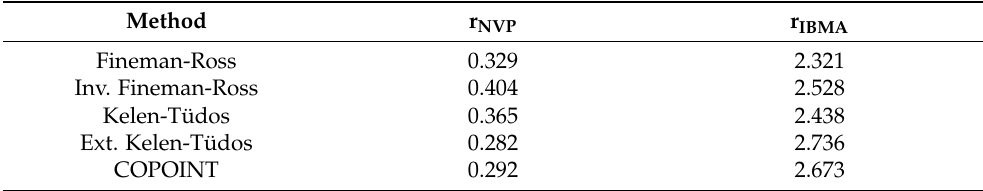
Table 3. Reactivity Ratios of NVP and IBMA in free radical